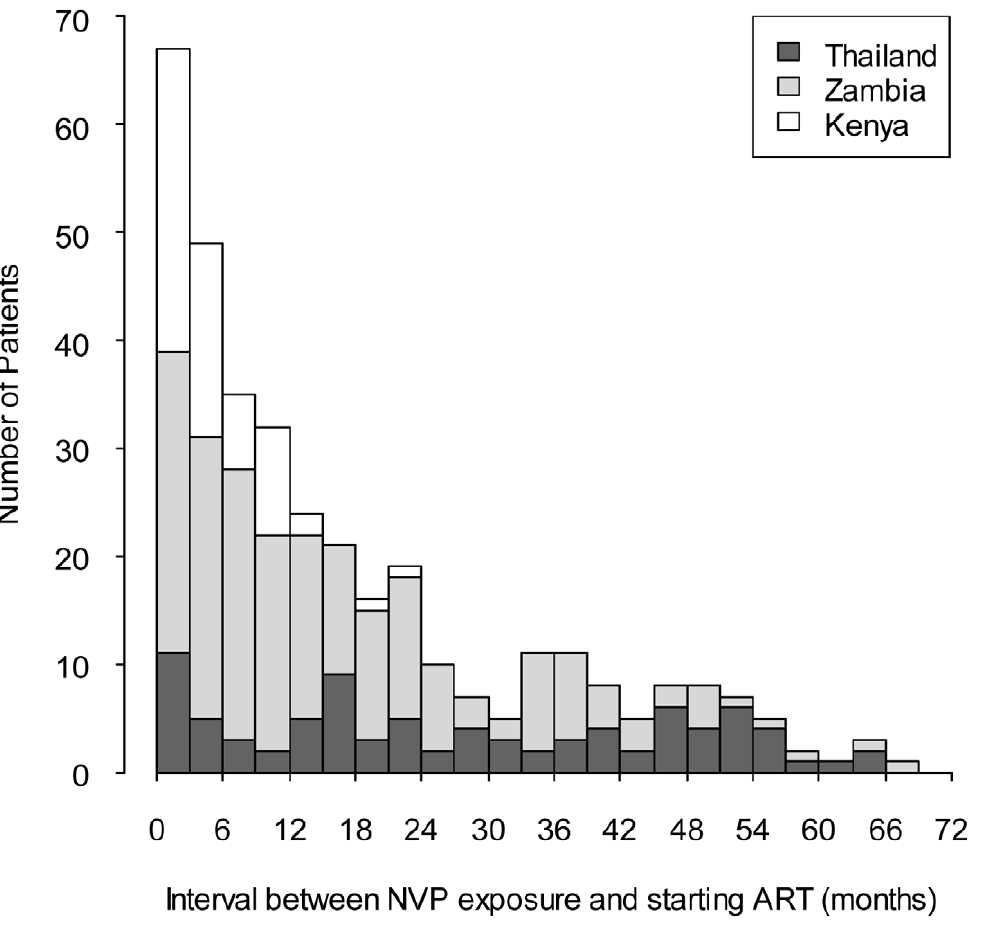
Figure 1. Interval between exposure to single-dose nevirapine and starting NNRTI-based antiretroviral therapy in the NNRTI Response Study—Zambia, Kenya, Thailand (2005 – 2008).